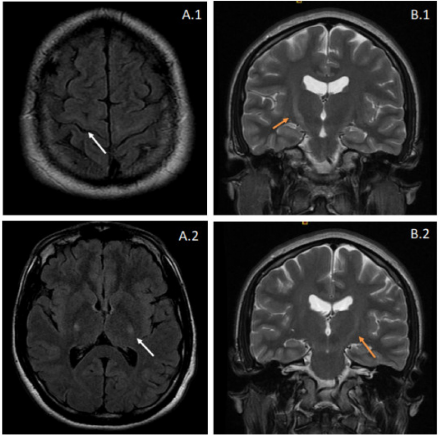
Figure 1. Brain MRI from the proband. Images ( A.1 , A.2 ) correspond to fluid-attenuated inversion recovery (FLAIR) sequences, showing hyperintensity affecting the pyramidal tracts bilaterally (white arrows). These features suggest degeneration of the corticospinal pathway and can also be observed in coronal T2-weighted images ( B.1 , B.2 ) as increased signal intensities at the internal capsule. The latter radiologic appearance is also known as the “Wine Glass”